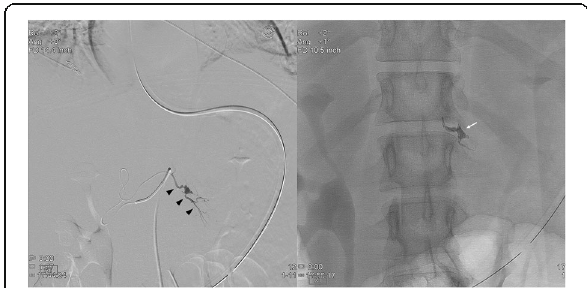
Fig. 3 a 28year-old male presenting with RUQ abdominal pain. Selective angiogram of a left hepatic artery branch demonstrates a PSA (arrowhead). b . Fluoroscopic image shows EVOH (Onyx 18) embolization leading to occlusion of afferent, efferent vessel and sac of PSA (arrow)